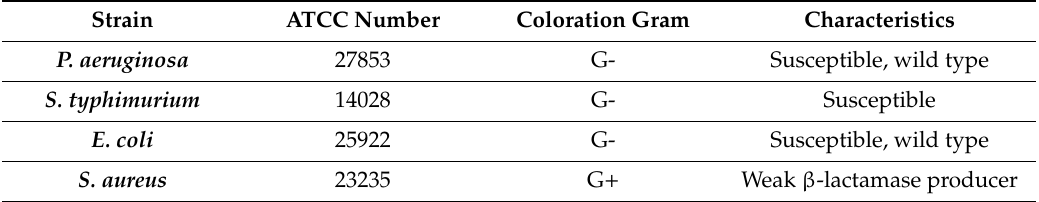
Table 1. Provenance and antibiotic resistance of bacterial strains used in the disc di ff usion test. Strain ATCC Number Coloration Gram Characteristics P. aeruginosa 27853 G- Susceptible, wild type S. typhimurium 14028 G- Susceptible E. coli 25922 G- Susceptible, wild type S. aureus 23235 G + Weak β -lactamase